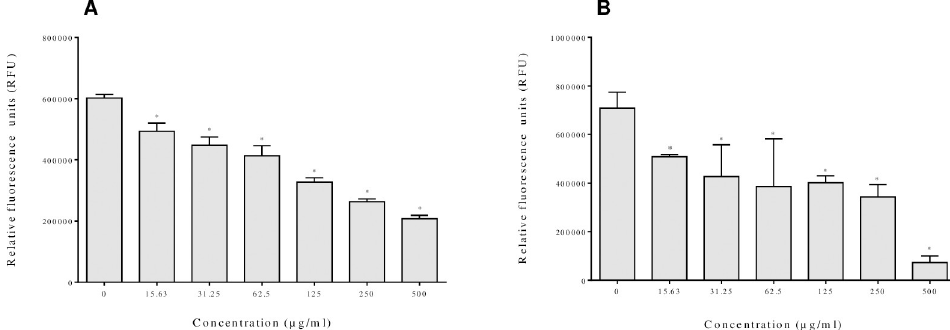
Fig 2. Effect of the cocoa extract on the adherence of F . nucleatum to oral epithelial cells (GMSM-K cell line) (Panel A) and the Matrigel ™ basement membrane model (Panel B). � , significant inhibition ( p < 0.01) compared to the control (no cocoa